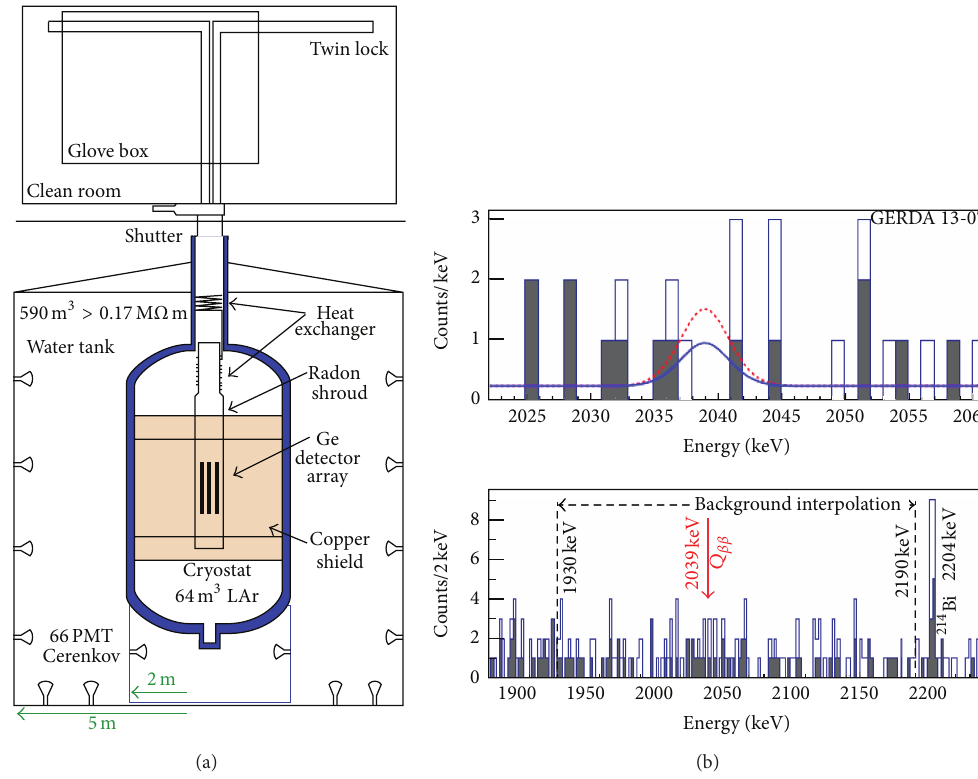
Figure12:(a)SchematicdrawingofthemaincomponentsoftheGERDAexperiment.(b)GERDAphaseIresults.Inthetoppanelisshownthe combined energy spectrum from all enriched Ge detectors without (open histogram) or with (filled histogram) PSA. The lower panel shows the region used for the background interpolation. In the upper panel, the spectrum zoomed to 𝑄 𝛽𝛽 is superimposed with the expectations (with PSD selection) based on the central value of KDHK [79, 80], 𝑇 0 ] 1/2 = 1.19 × 10 25 yr (red dashed line) and with the GERDA phase I result 𝑇 0 ] > 2.1 × 10 25 yr at 90% C.L. (blue solid line). (Figure and description from 1/2